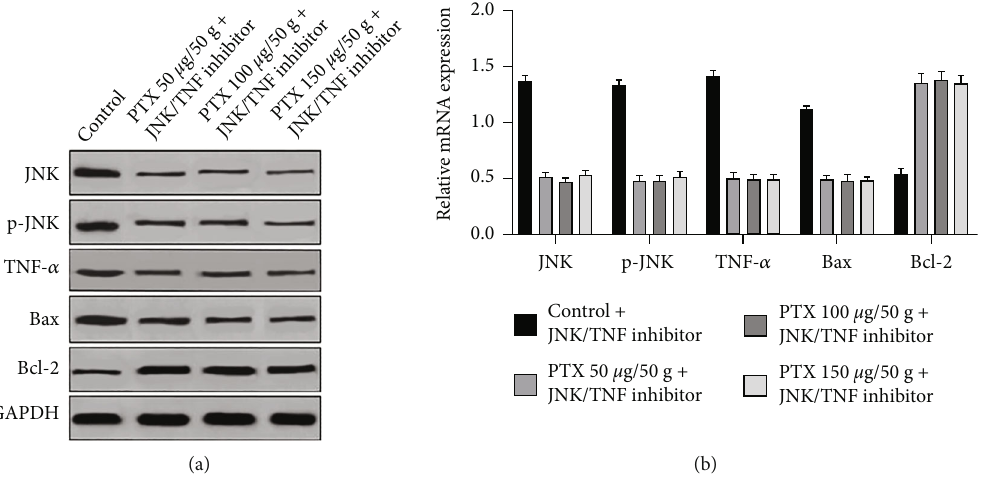
Figure 4: The e ff ect of inhibiting c-Jun N-terminal kinase (JNK) and tumor necrosis factor (TNF- α ) on cardiomyocyte apoptosis in mice after Paclitaxel (PTX) intervention. (a) Bax and Bcl-2 protein expression related to myocardial apoptosis. (b) The expression of Bax and Bcl- 2 mRNA related to myocardial